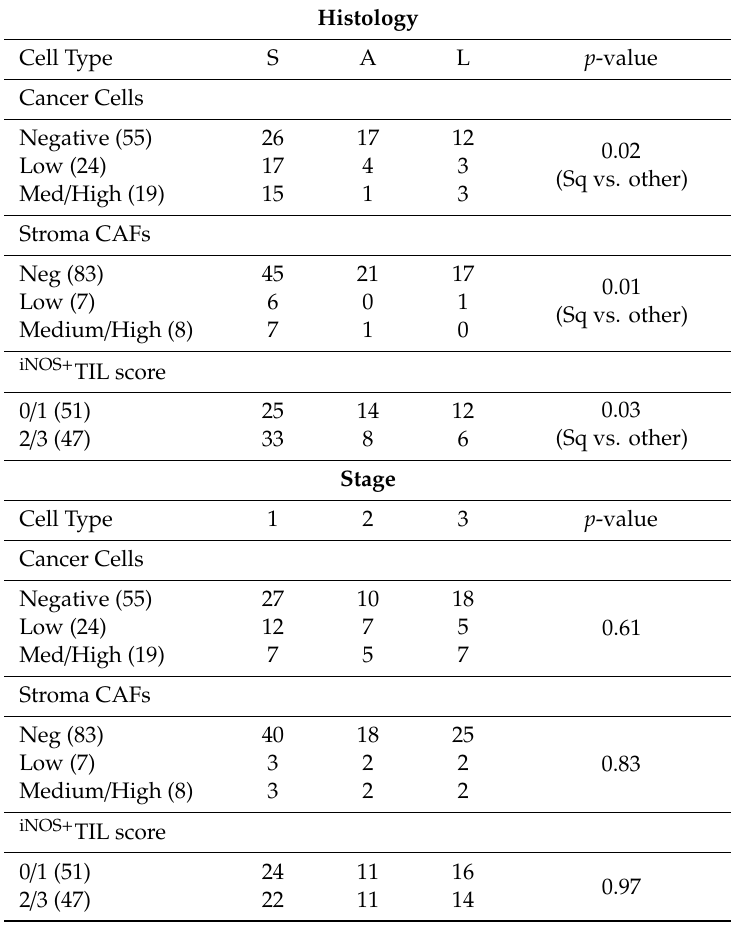
Table 2. Association of iNOS expression with histopathological parameters.